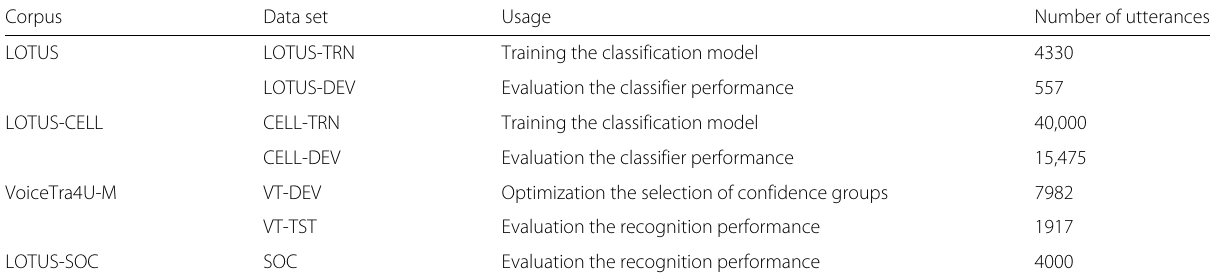
Table 3 The detail of each speech corpora set used in this study